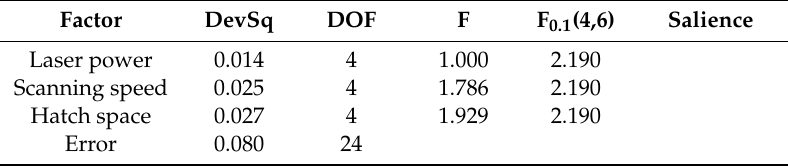
Table 8. Significant level of each factor under a layer thickness of 60 μ m.